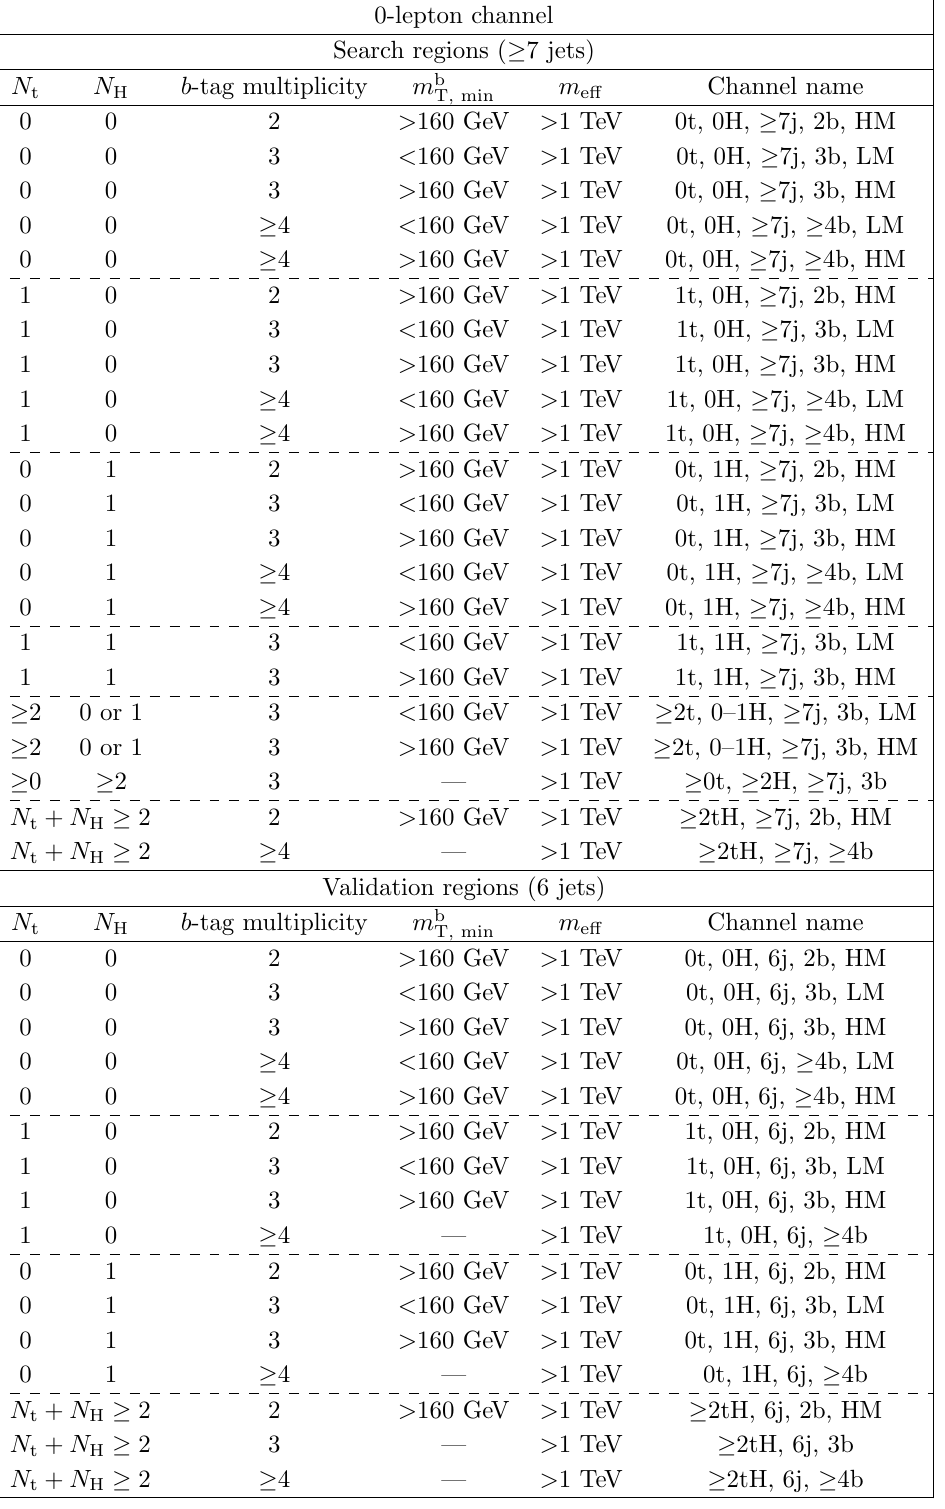
Table 3. De(cid:12)nition of the search and validation regions (see text for details) in the 0-lepton